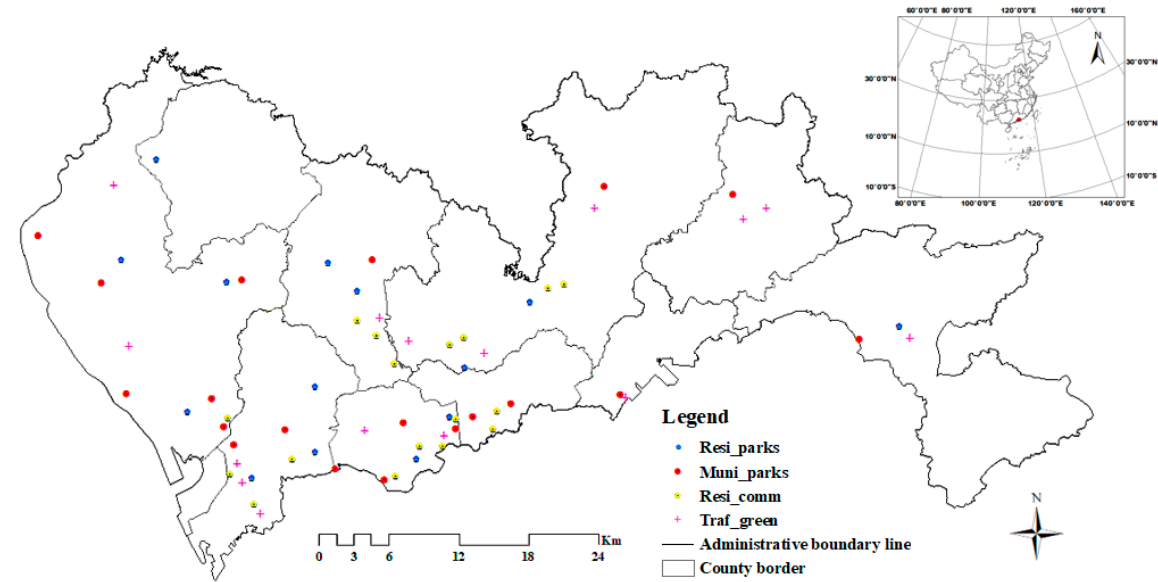
Figure 1. Study area and geographical distribution of our sampling sites.